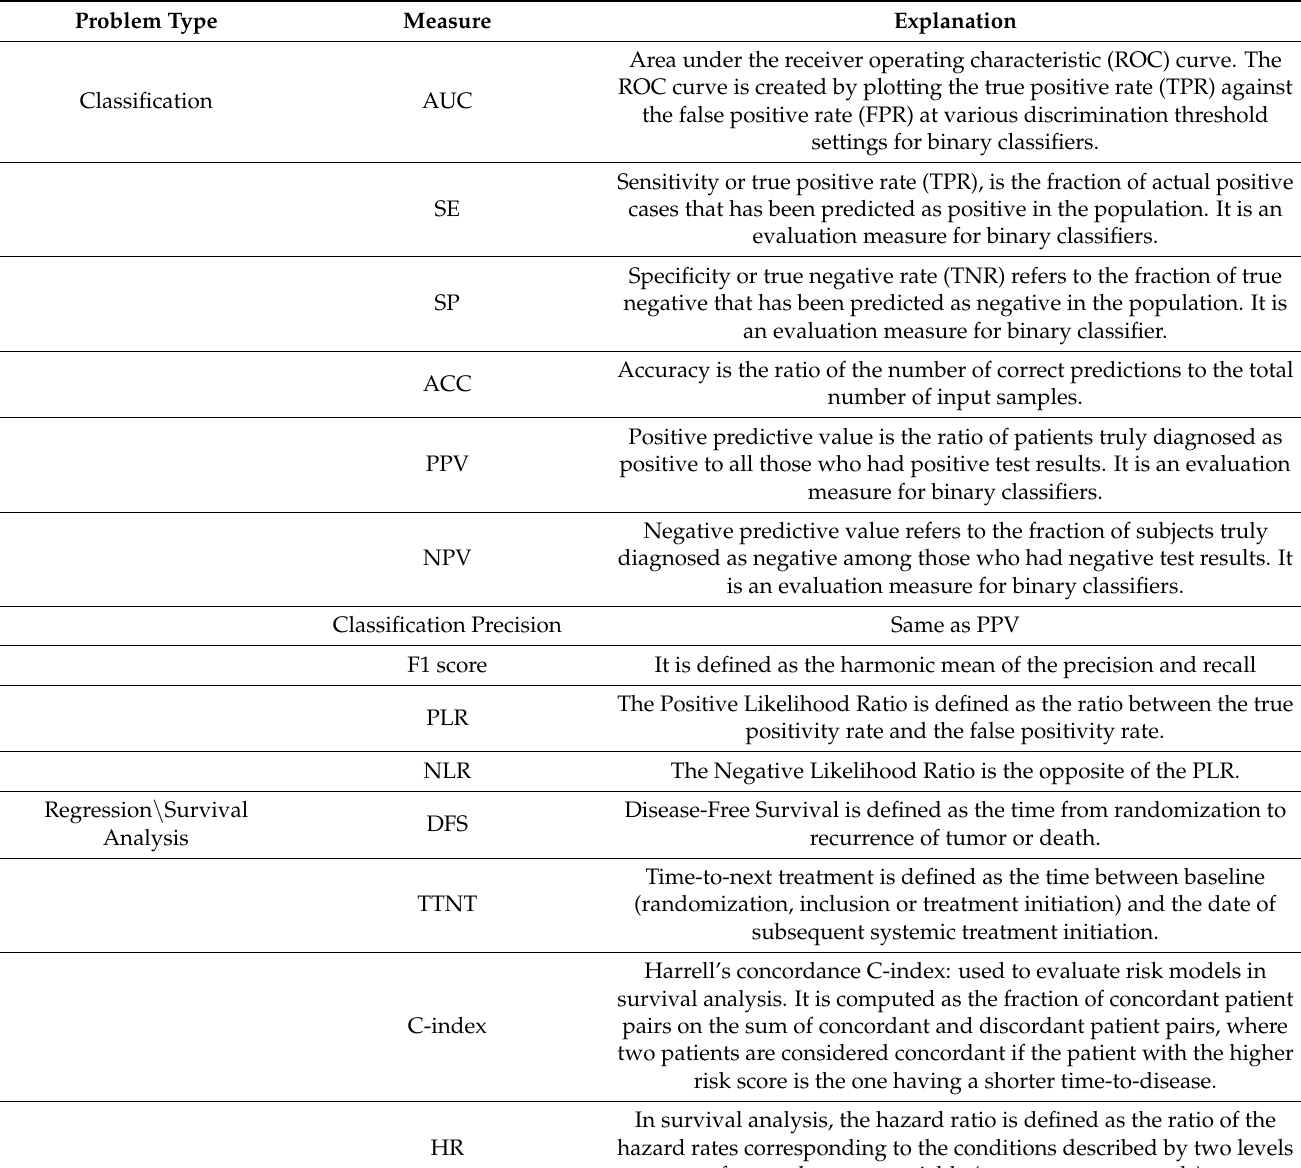
Table 1. Evaluation